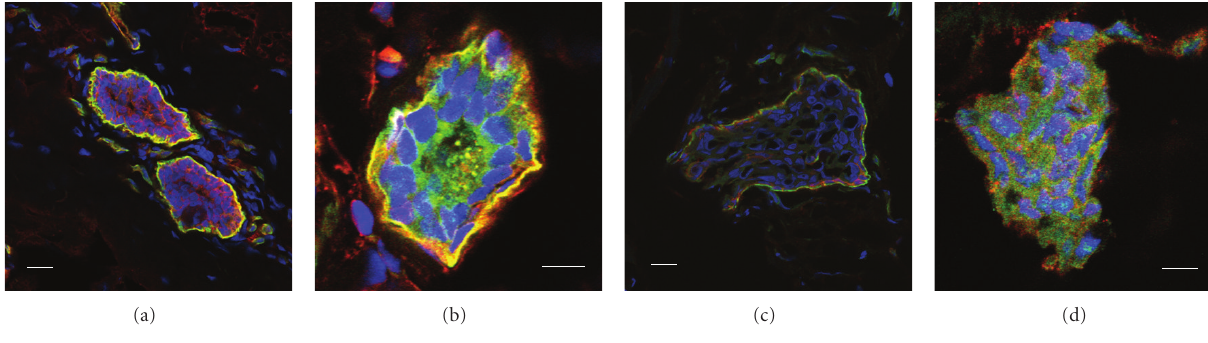
Figure 9: Tissue samples from human patients exhibit variations in acini morphology along the metastatic cascade similar to the 3D cultures. In the nontumorigenic glands from a healthy patient shown in (a), integrin α 3 can be observed along the lateral surface of the epithelia, while integrin α 6 shows strong staining across the basal surface. Precancerous gland shown in (b) exhibits a clear reduction in the amount of integrin α 3 expression along the lateral membranes of the epithelia, while basal integrin α 6 expression remains strong. Noninvasive carcinoma gland shown in (c) could be easily identified by the loss of a proper hollow lumen and stratification of the epithelial layer. In these large regions of tissue, integrin α 3 is absent from cells in the interior of the gland; however, along with integrin α 6, there can be observed along the basal surfaces of cells in contact with the basal lamina. Invasive carcinoma gland shown in (d) includes cords or clusters of cells exhibiting faint labeling of both proteins distributed along the cell membrane compared to background and control tissue. Scale bars represent 20 μ m in (a) and (c), and 10 μ m in (b) and